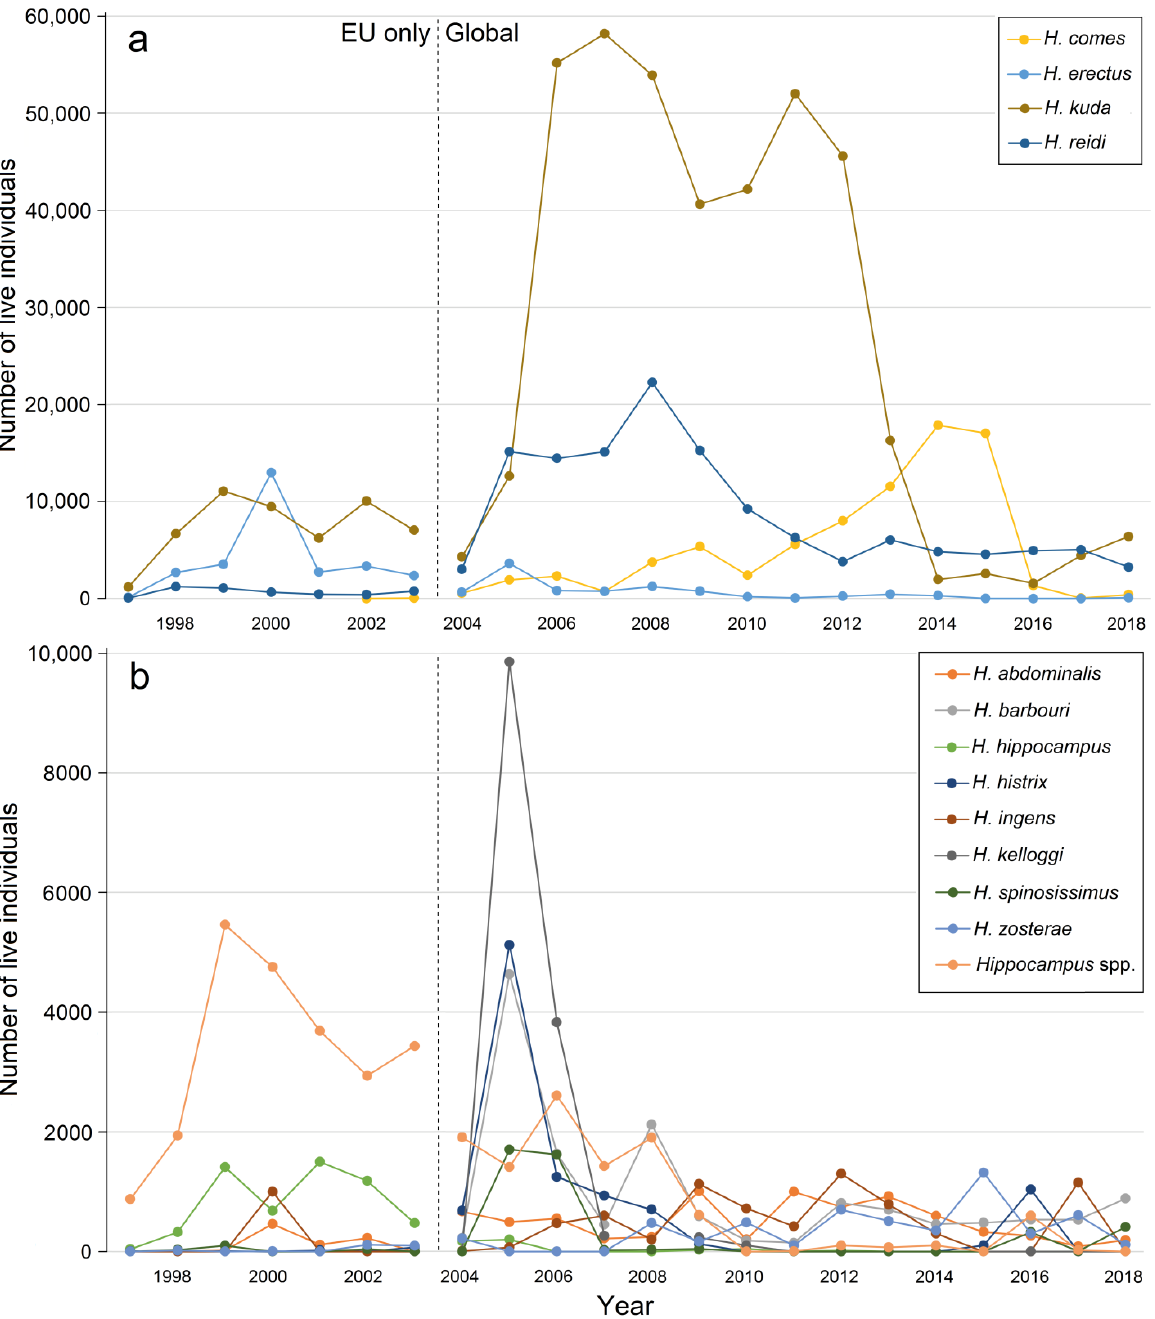
Figure 4. Annual trade records of live seahorses based on import data of the 12 internationally most traded species in the periods 1997 – 2003 (pre-CITES records from the EU) and 2004 – 2018 (global) [69]: ( a ) high annual numbers; ( b ) lower numbers.